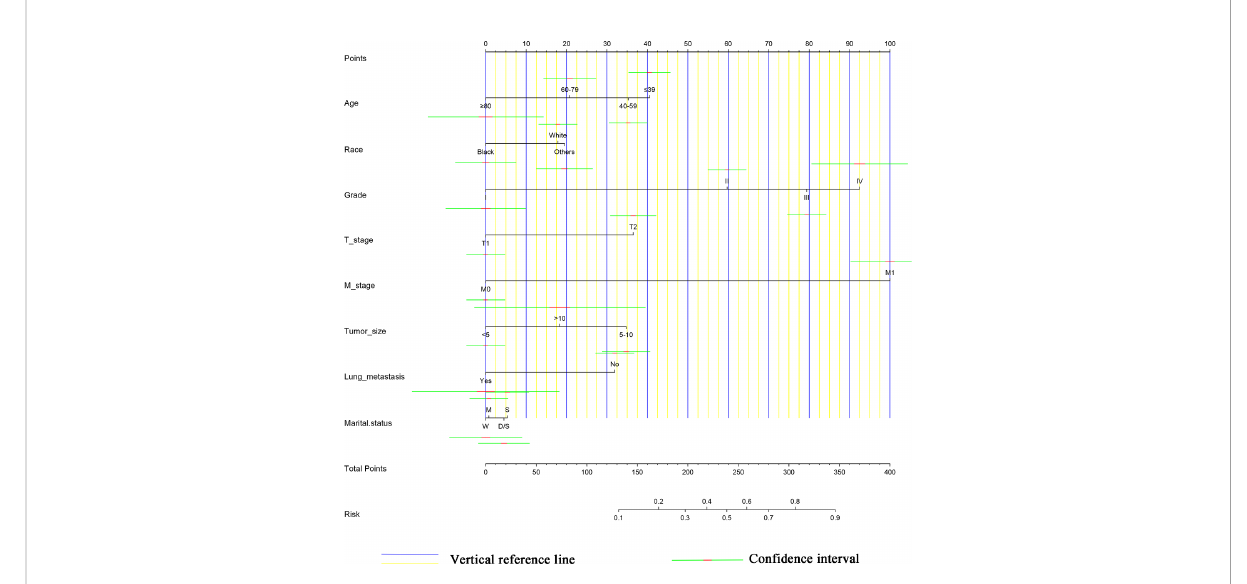
FIGURE 3 Nomogram for T 1-2 -stage CC. S, Single; M, Married; D/S, Divorce/Separation; W,